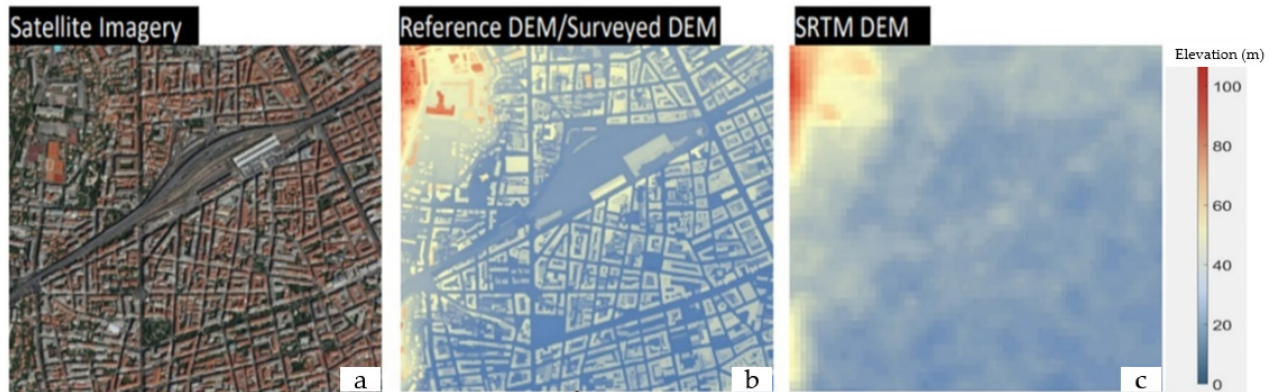
Figure 1. Display of sample data in Nice, France: ( a ) Satellite image, ( b ) elevation map of reference DEM and ( c ) SRTM DEM.